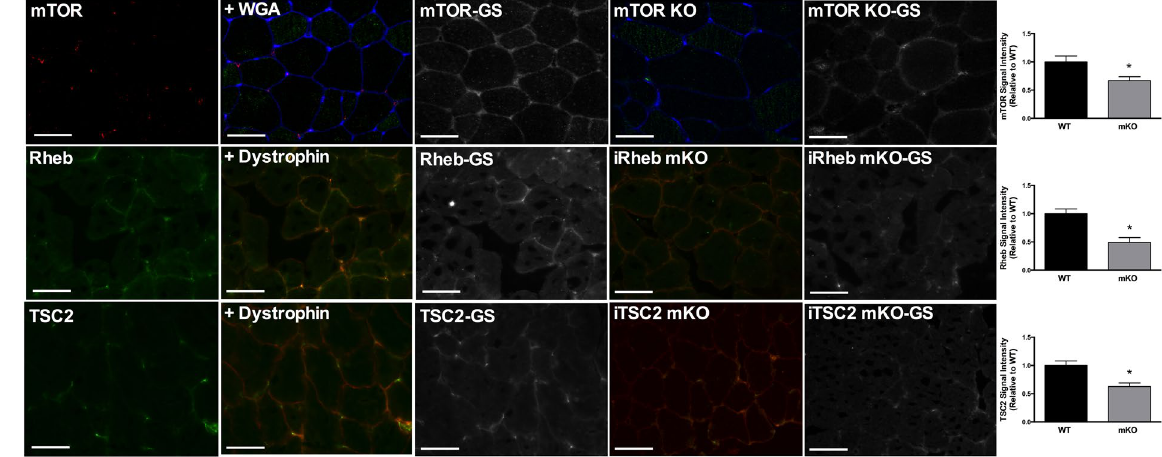
Figure 1. mTOR, Rheb and TSC2 antibody validation. Immunofluorescence labeling of endogenous proteins was performed as described in the Methods section. Cross-sections were stained with the antibodies relating to mTOR, Rheb and TSC2 in wild-type mice (WT – Left panel) or in muscle from mTOR, Rheb and TSC2 knockout mice (mKO). Regionality of staining is provided through co-staining with WGA or Dystrophin as a marker of the cell membrane. All image processing was kept constant between images, including exposure time, gain, and image frame. GS – Grey scale image * Significantly different to WT ( P <